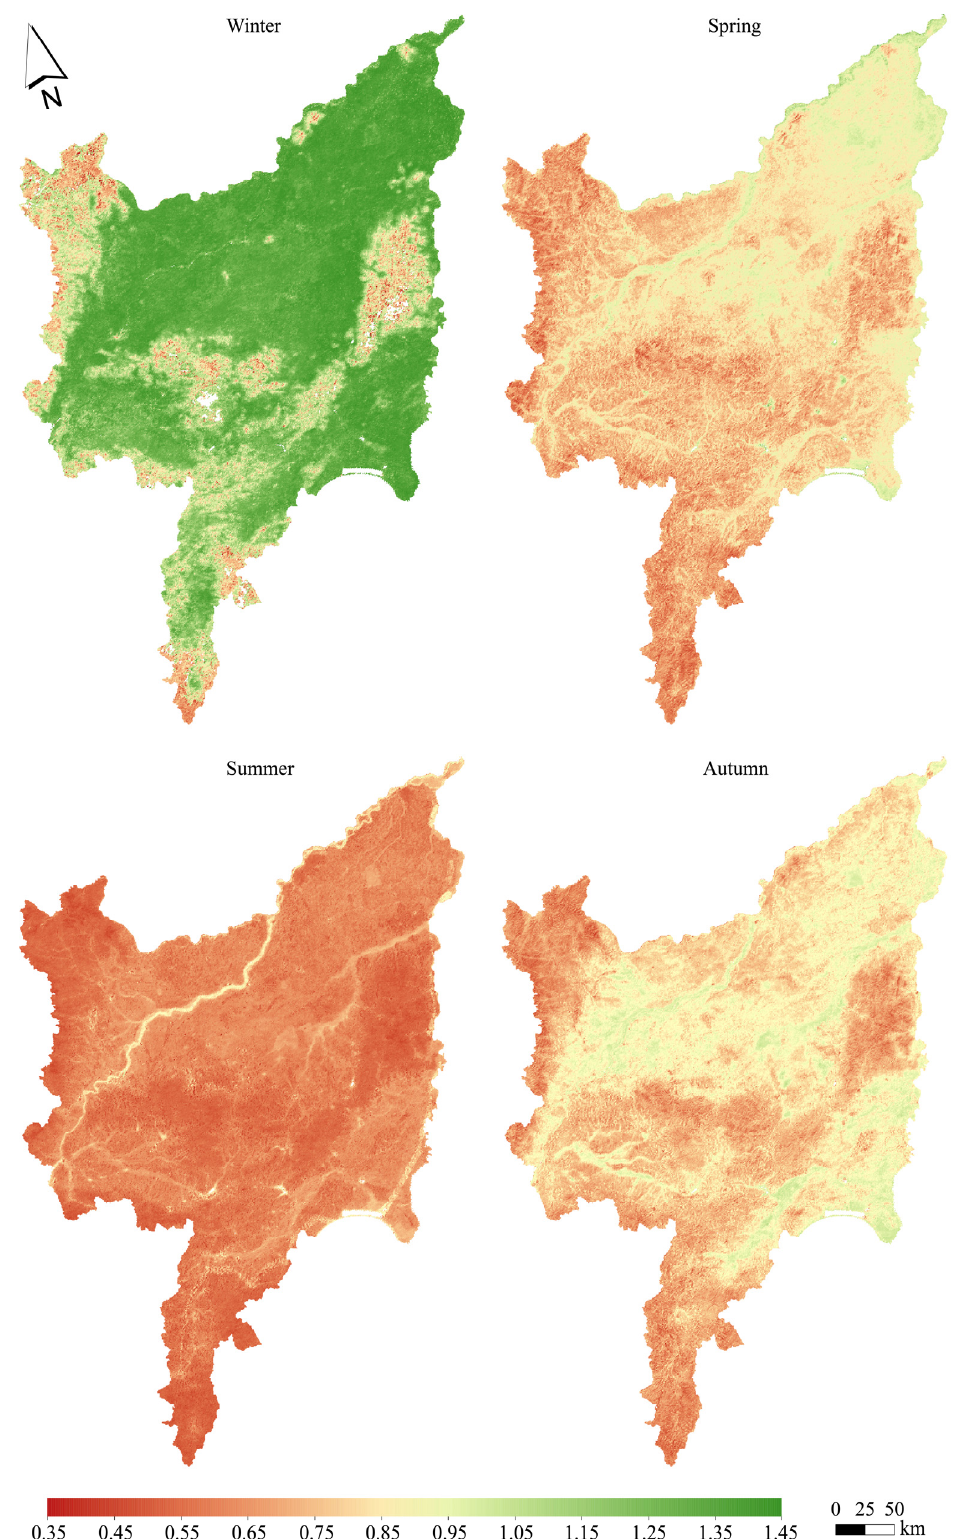
Figure 9. Spatial distribution of the multiyear mean CI for each season. The CI variation trend with elevation in each season was explored based on the pixel- level statistics of the seasonal multiyear mean CI and elevation. As shown in Figure 10, the multiyear mean CI of each season exhibited a slight downward trend with elevation.